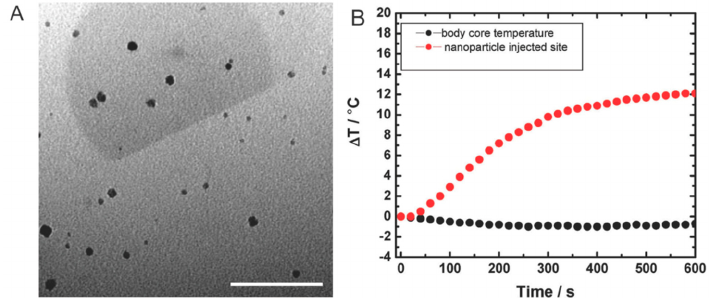
Figure 1. ( A ) Transmission electron microscope image of IONP fabricated with a dopamine-anchored shell, scale bar, 100 nm; ( B ) Quantitative analysis depicted the temperature changes at the nanoparticle Images reproduced from [25], with permission from BioMed Central Ltd., 2010. injection site versus the body core as measured with a fiber optic temperature probe. Images reproduced from [25], with permission from BioMed Central Ltd.,